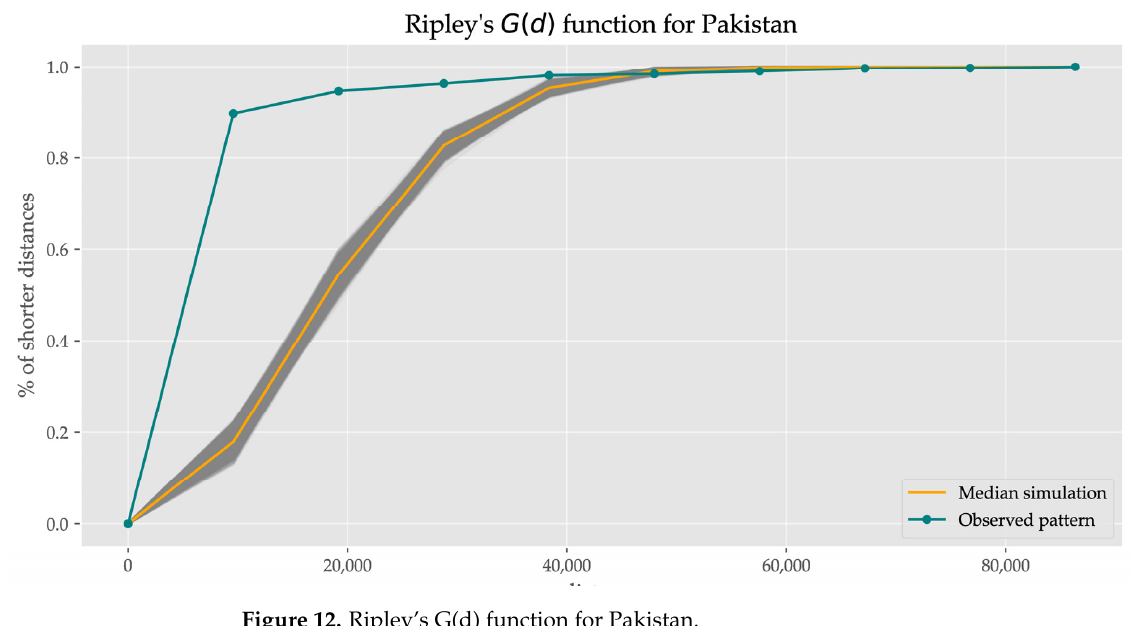
Figure 12. Ripley’s G(d) function for Pakistan.